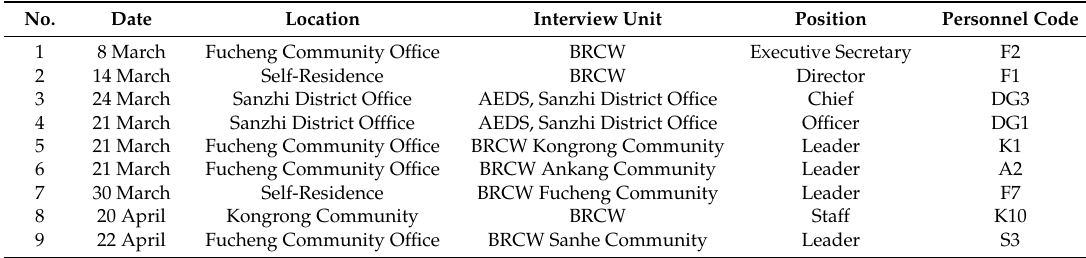
Table 2. Qualitative interview interviewee information.